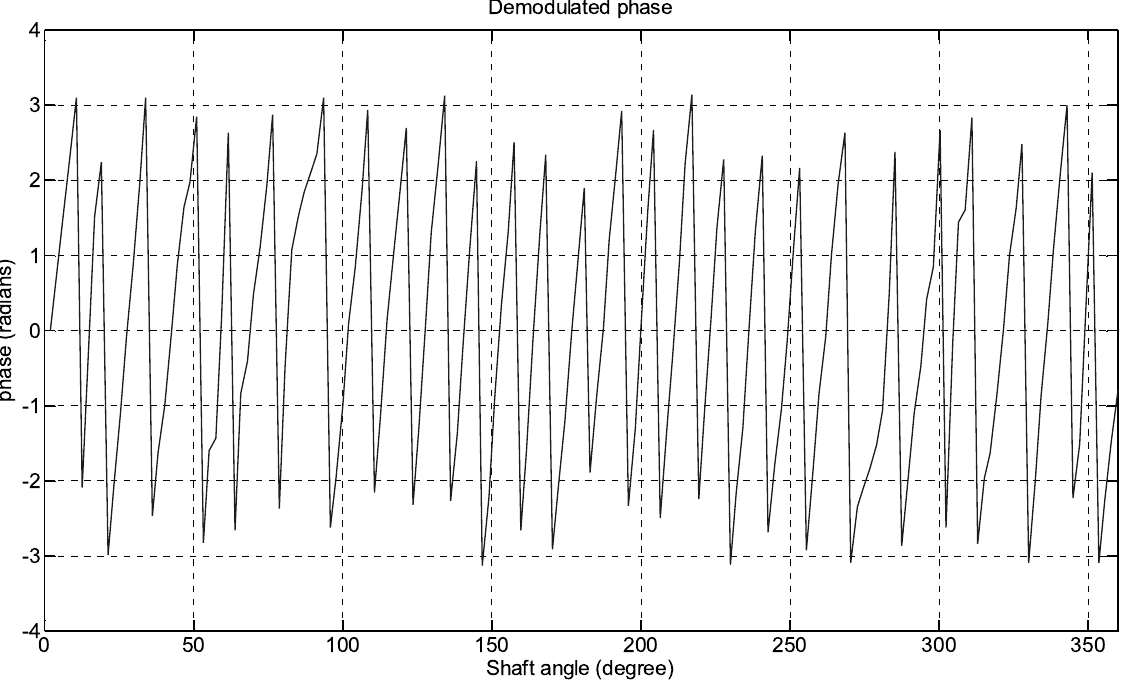
Fig. 26. Phase diagram of the residual signal at the 9th harmonic for the broken